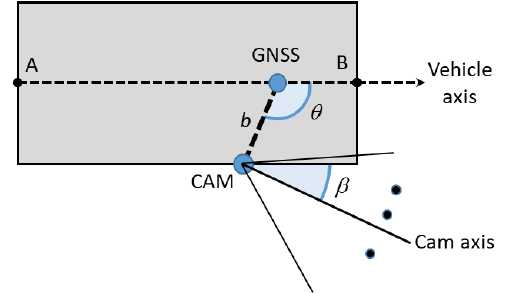
Figure 3. Planar scheme of the vehicle with the GNSS antenna and the camera (CAM), camera axis and surveyed points The points surveyed in front of the camera, also seen on a video collected by the camera, are used to estimate a point in the centre line of the camera, and so calculate angle  , between the vehicle axis and the trajectory. In the present case the value obtained for  was 26.1º. It will be used to calculate the azimuth of the camera axis for any image.